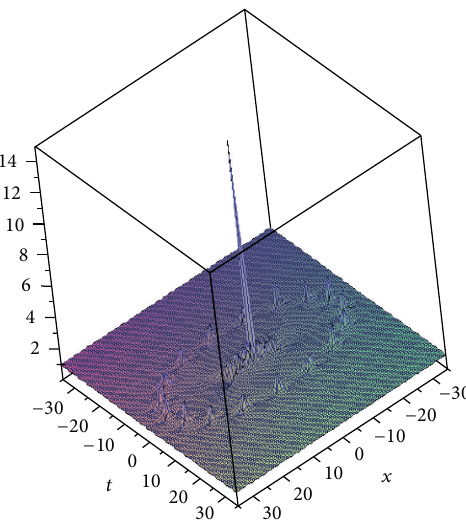
Figure 3: Solution of NLS, 𝑁 = 9 , 𝑎 1 = 10 16 , 𝑏 1 = −10 12 .